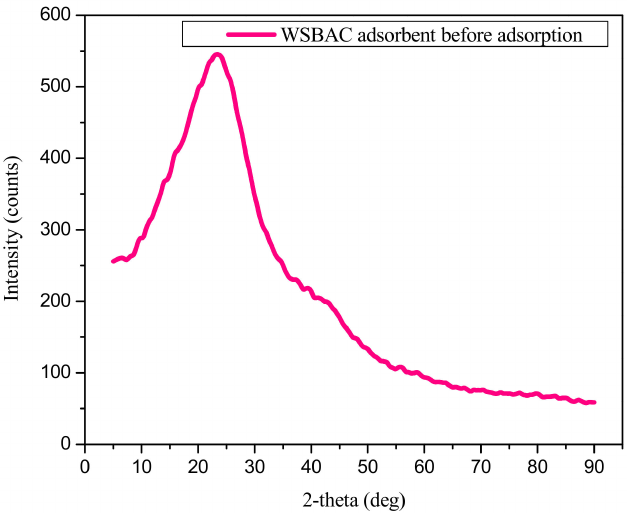
Figure 5. X-ray diffraction (XRD) pattern of WSBAC adsorbent before RBBR dye